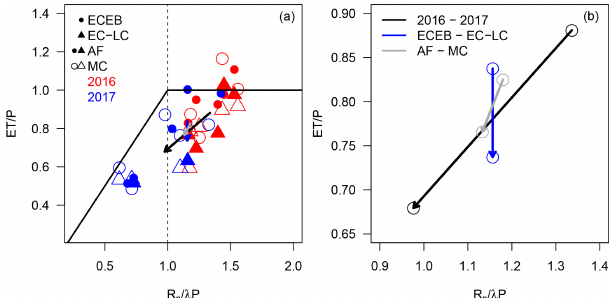
Figure 11. (a) Evapotranspiration index (ET /P ) vs. the radiative dryness index ( R N /λP ) for both land uses (AF – filled triangles and dots; MC – empty triangles and dots), both set-ups (ECEB – dots; EC-LC – triangles), and both years (2016 – red; 2017 – blue). The bold black line describes the regions of an energy limitation ( R N /λP < 1) and a water limitation ( R N /λP > 1). The arrows in- dicate the mean trends of ET for the effect of different years (black arrow), different methods (blue arrow), and different land uses (grey arrow). (b) Trends of the mean evapotranspiration index (ET /P ) vs. the mean radiative dryness index ( R N /λP ) for the effect of differ- ent years (black), different methods (blue), and different land uses (grey) extracted from (a)